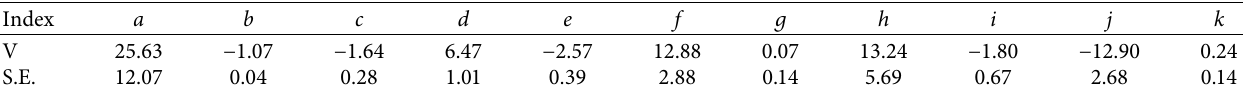
Table 12: Fitting results of parameters in the model of evaluating the wettability of surfactants to bituminous coal. Index